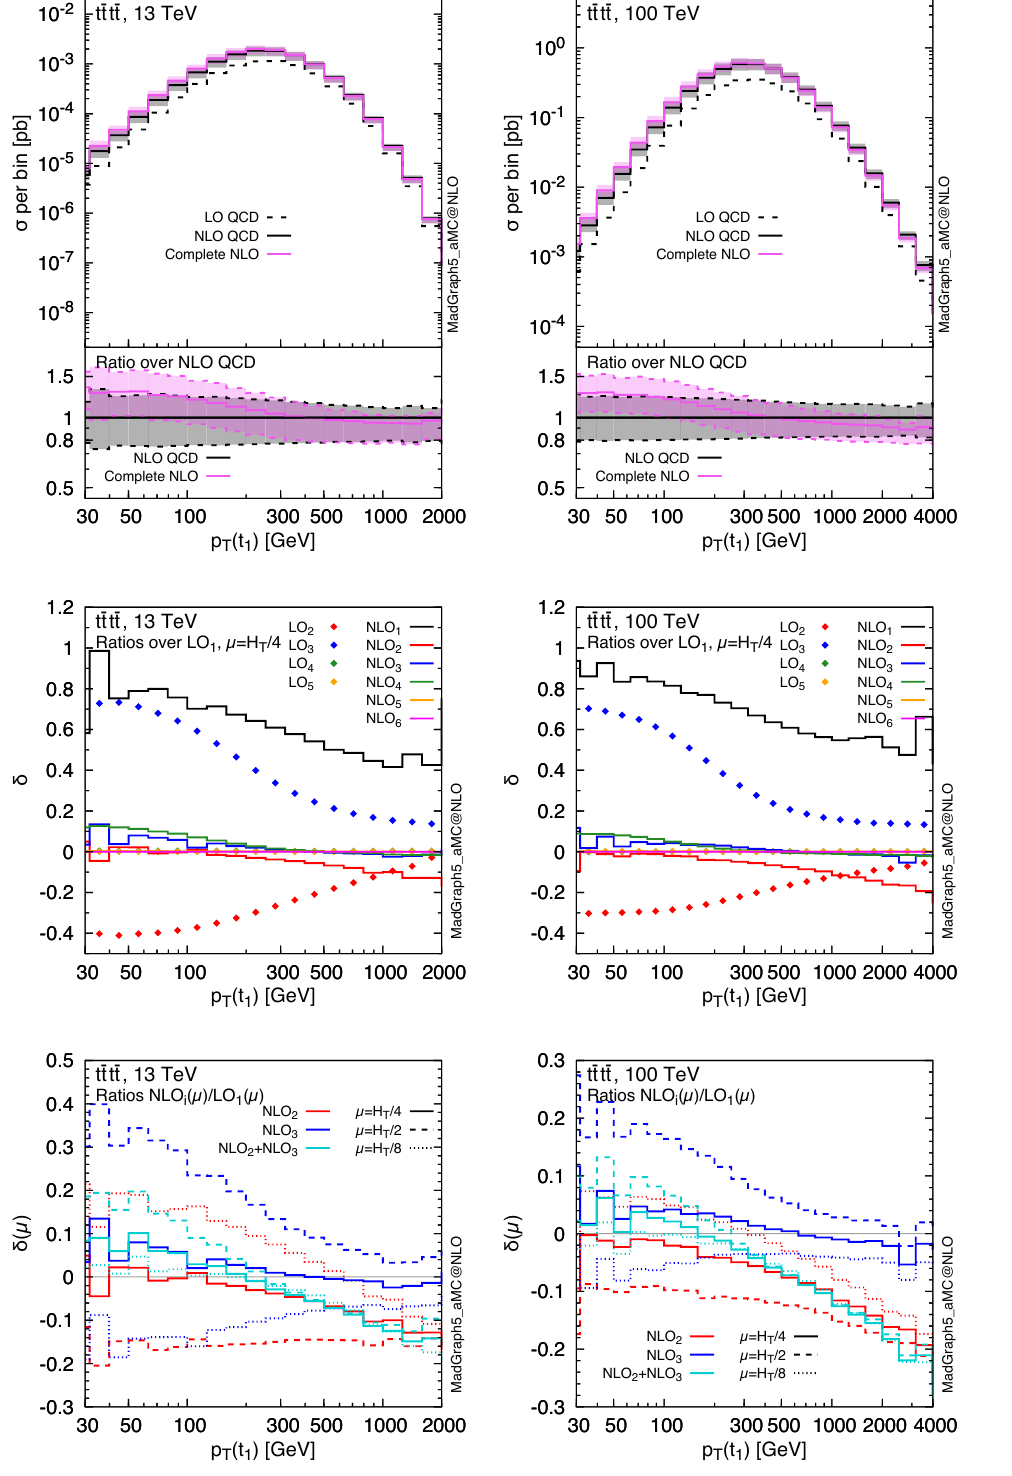
Figure 11 . The p T ( t 1 ) distribution in t (cid:22) tt (cid:22) t production. See the caption of (cid:12)gure 9 for the description of the plots.